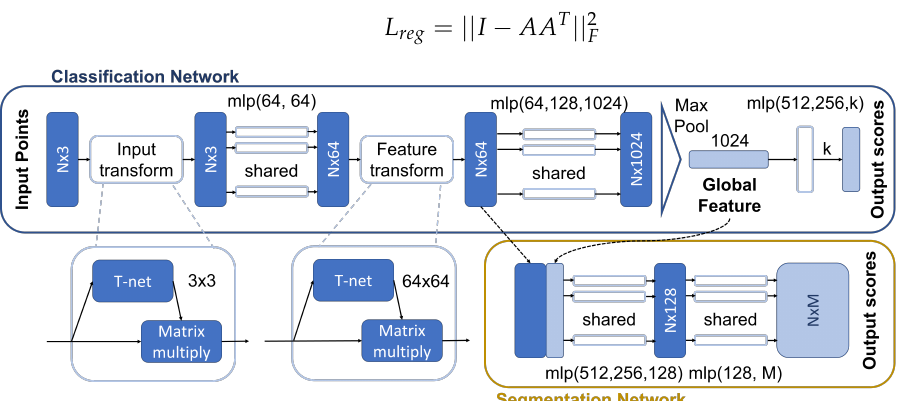
Figure 4. PointNet [49]